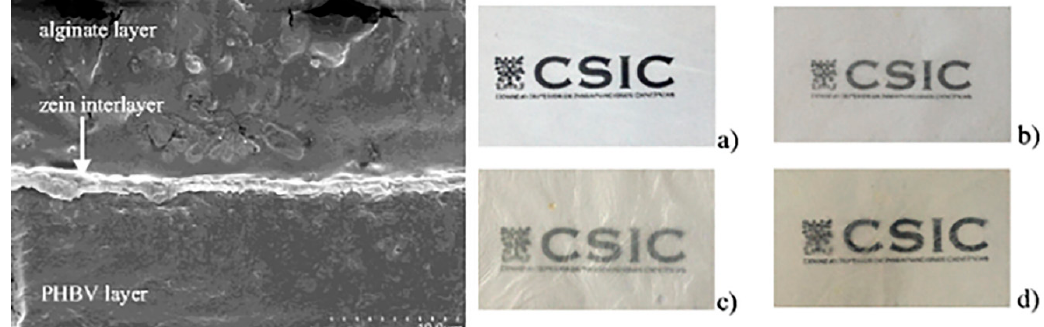
Figure 3. Left : SEM micrograph of TD fracture surface, poly(hydroxy butyrate-co-valerate) (PHBV)/zein/alginate film; right : images of several multilayer systems: a ) PHBV; b ) PHBV/zein+CNMA; c ) PHBV/zein + CNMA/PHBV; d ) PHBV/zein+CNMA/alginate [17] (reproduced with permission from SpringerNature).